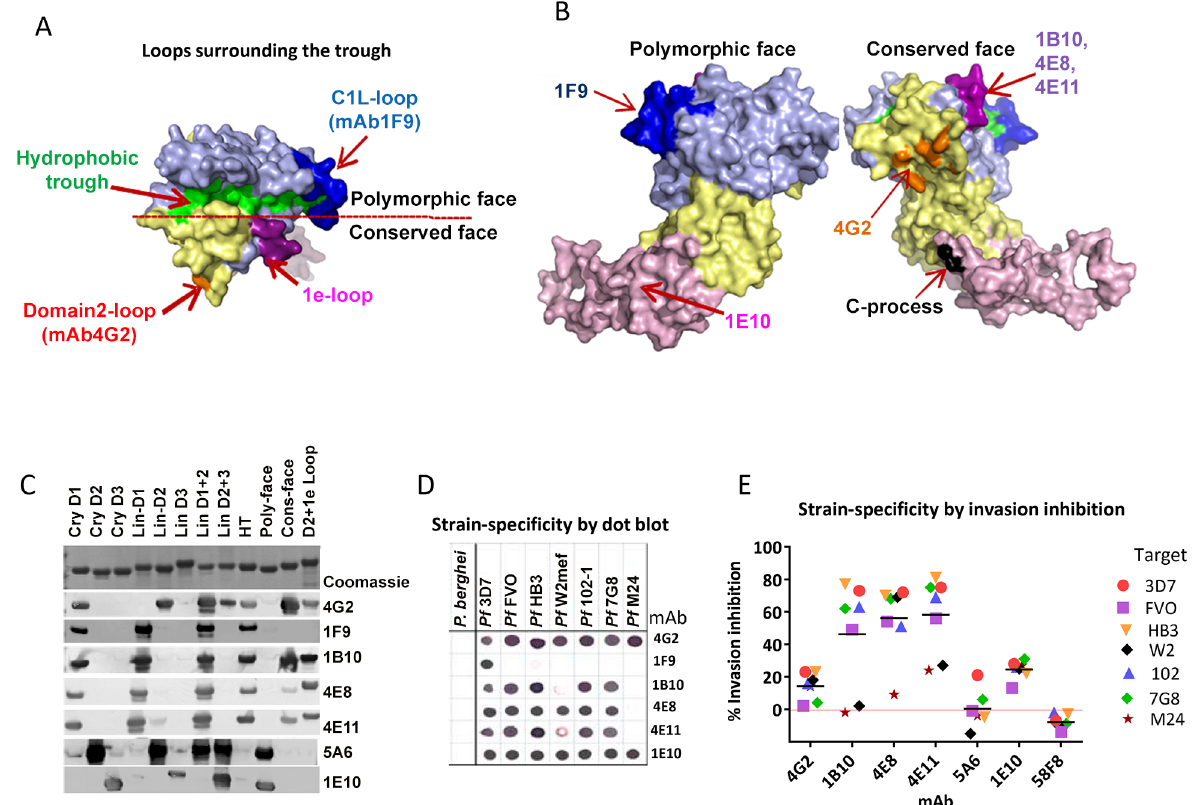
Figure 4. Mapping inhibitory monoclonal antibodies. ( A ) View of the hydrophobic trough and the surrounding loops showing approximate spatial location of mAb epitopes. ( B ) Polymorphic and conserved face of AMA1. Domain-1 residues (light blue); domain-2 (yellow); domain-3 (magenta); C-terminal processing site at residue Thr 517 (black); mAb 4G2 binding residues (orange); mAb 1F9 epitope centered on the C1L-loop (dark blue); and mAb 1B10, 4E8 and 4E11 epitopes on the 1e-loop (purple). ( C ) Coomassie blue stained and western blot panels showing chimeric proteins (Fig. S5) used to map representative mAbs. ( D ) Dot blot reactivity pattern of inhibitory mAbs against diverse P. falciparum AMA1 allelic proteins and P. berghei AMA1 control. ( E ) A cross-strain GIA against 7 parasite strains at 1 mg/ml mAb concentration.